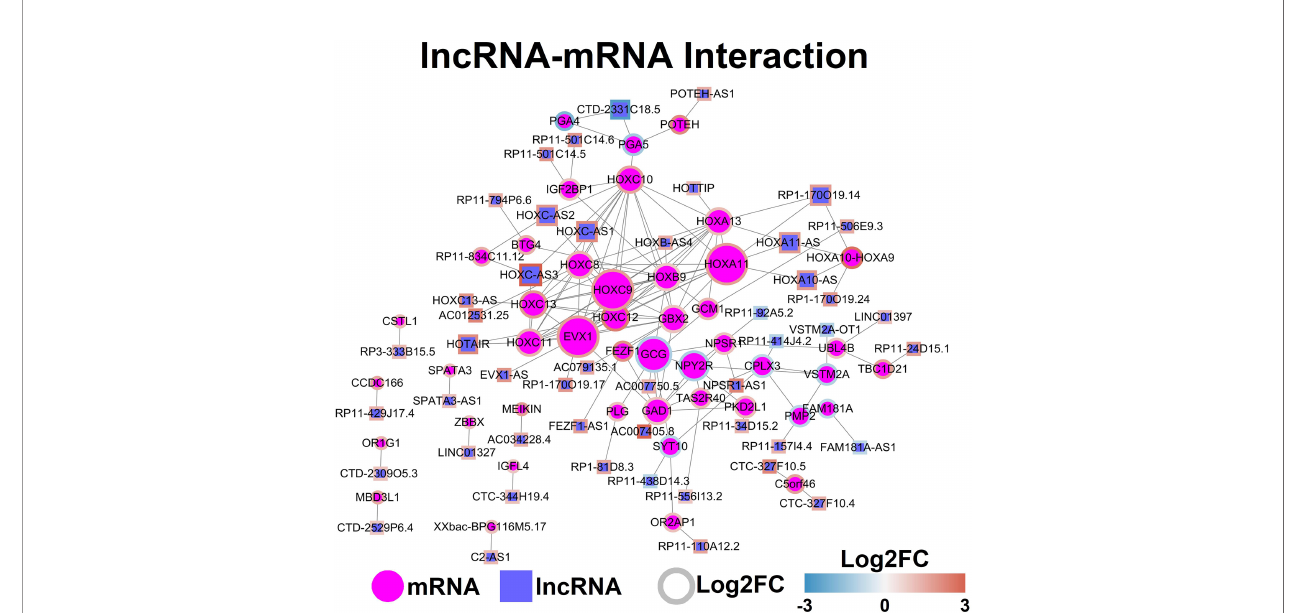
FIGURE 4 | LncRNA-mRNA network. Each node represents one gene, and each edge represents the interaction between genes. LncRNAs and mRNAs are indicated using circular shapes and circle shapes respectively.